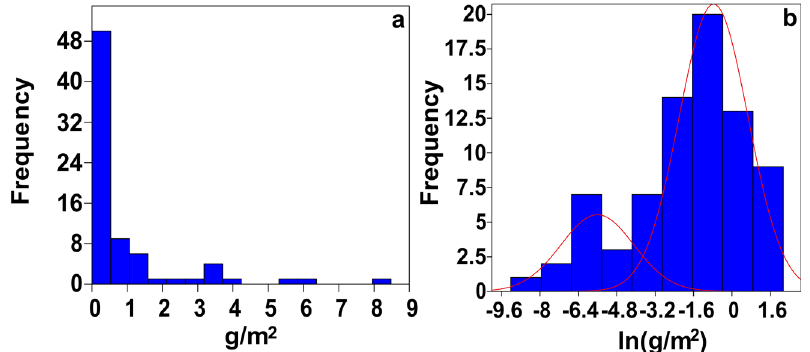
Figure 5. ( a ) Histogram of the variable g/m 2 of the LDG sampled points; ( b ) Histogram of the logarithmically transformed